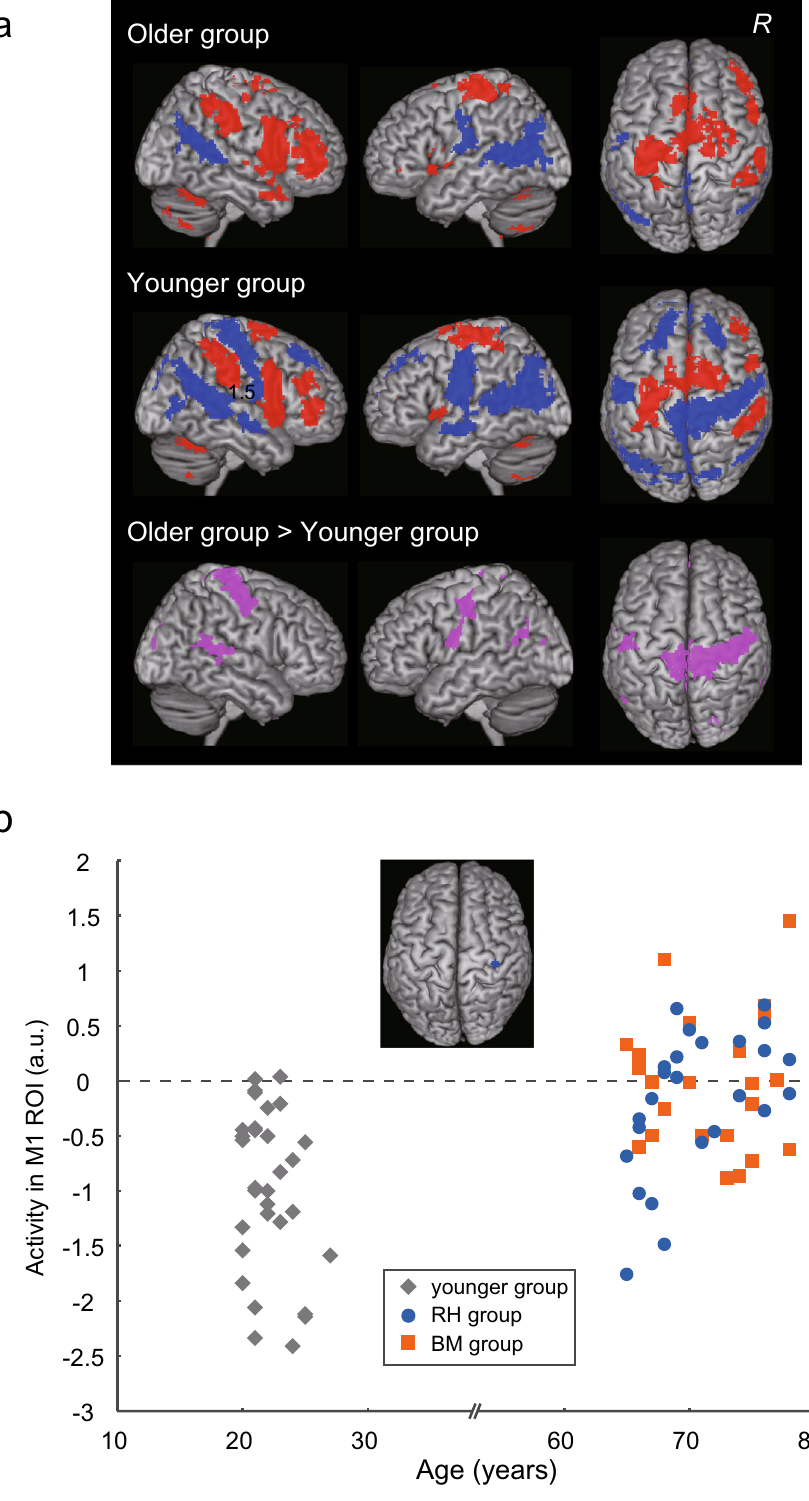
Figure 3. Brain deactivations and activations in the younger and older groups before training. ( a ) Brain deactivations (blue) and activations (red) observed during the illusion in the older (top) and younger (middle) groups. Table S4 summarizes the deactivations and activations. The pink areas indicate brain regions with greater activity in the older group than in the younger group (bottom). Table S5 summarizes the age-group difference results, which are rendered on the cortical surface of the MNI standard brain. In each row, the left panel indicates the right-side view, the middle panel indicates the left-side view, and the right panel indicates the top view of the brain. ( b ) Relationship between the parameter estimate of ipsilateral M1 ROI activity (a.u.; vertical axis) and age (horizontal axis). The blue section in the top panel indicates the ipsilateral M1 ROI. The data indicated below a dashed line indicate deactivation. The gray diamonds represent the data obtained from the younger group. The orange squares represent individual data obtained from the BM group. The blue circles indicate data from the RH group. a.u. arbitrary unit, BM bimanual, MNI Montreal Neurological Institute, R right hemisphere, RH right